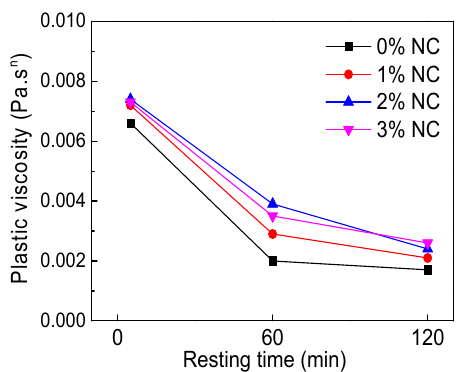
Figure 19. Influence of resting time on K.